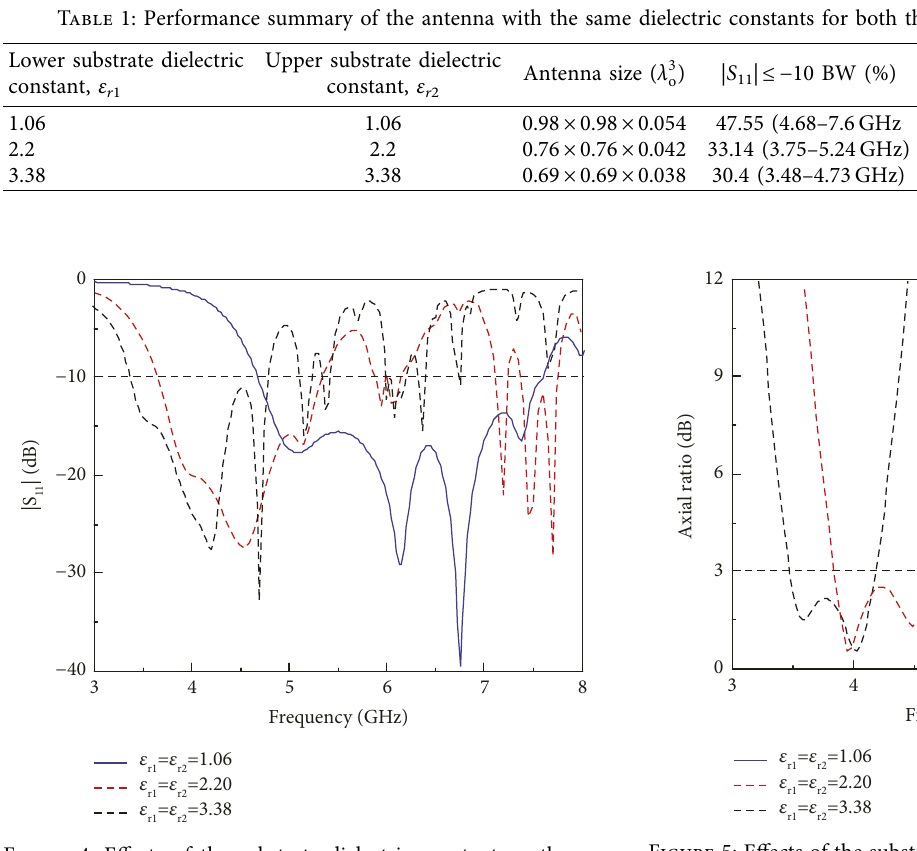
Figure 4: Effects of the substrate dielectric constant on the re- flection coefficient of the antenna.